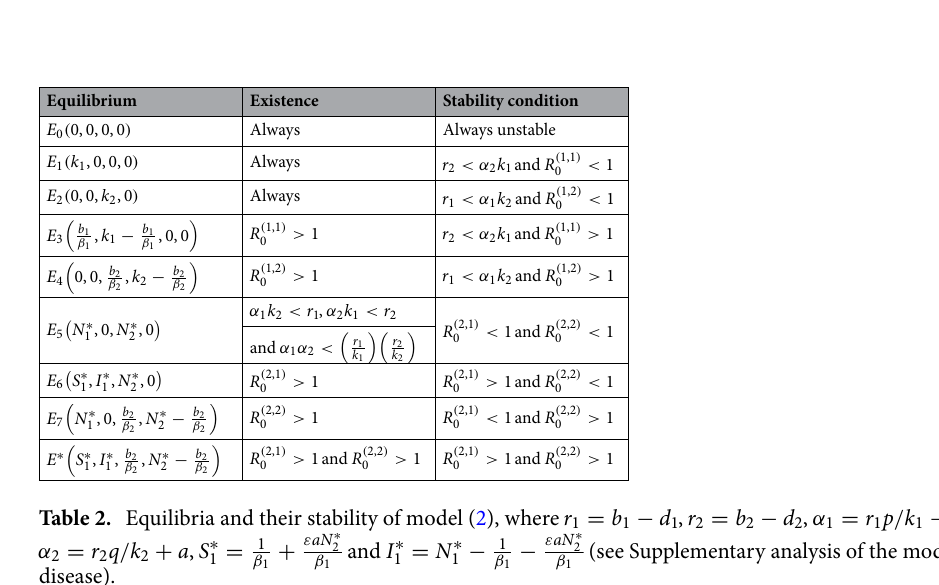
∗ ∗ 2 2 + ε aN − ε aN I ∗ 1 = N ∗ 1 − 1 β 1 β 1 and β 1 β 1 (see Supplementary analysis of the model